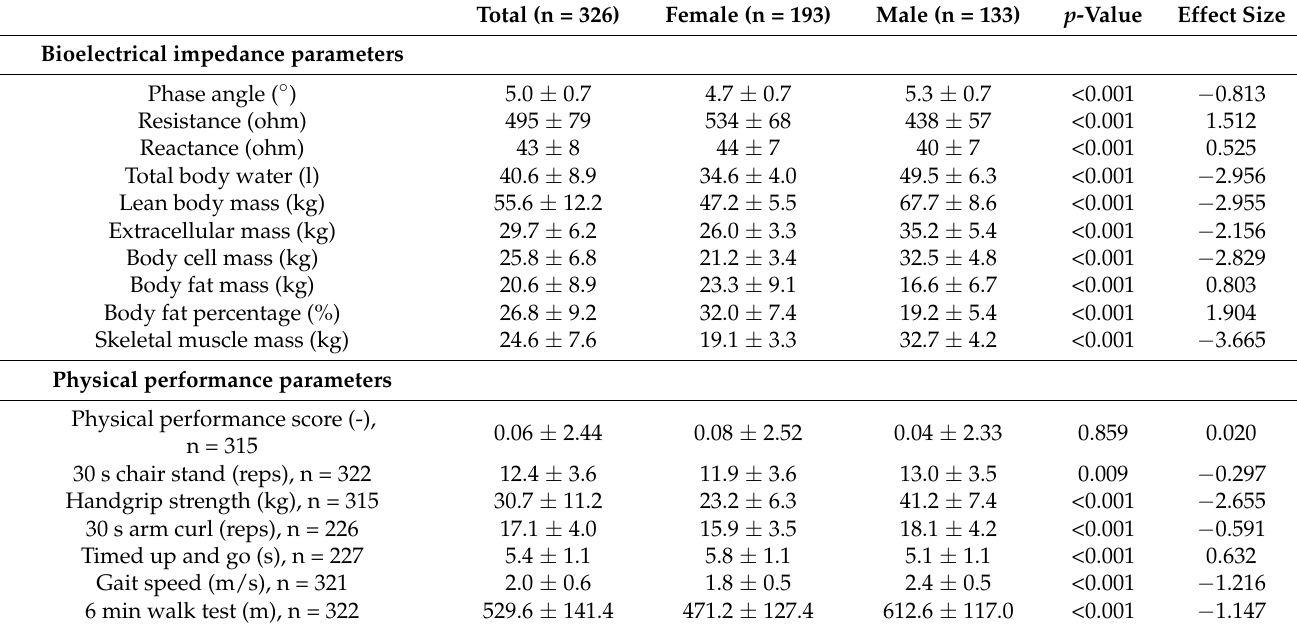
Table 2. Bioelectrical impedance analysis and physical performance parameters.